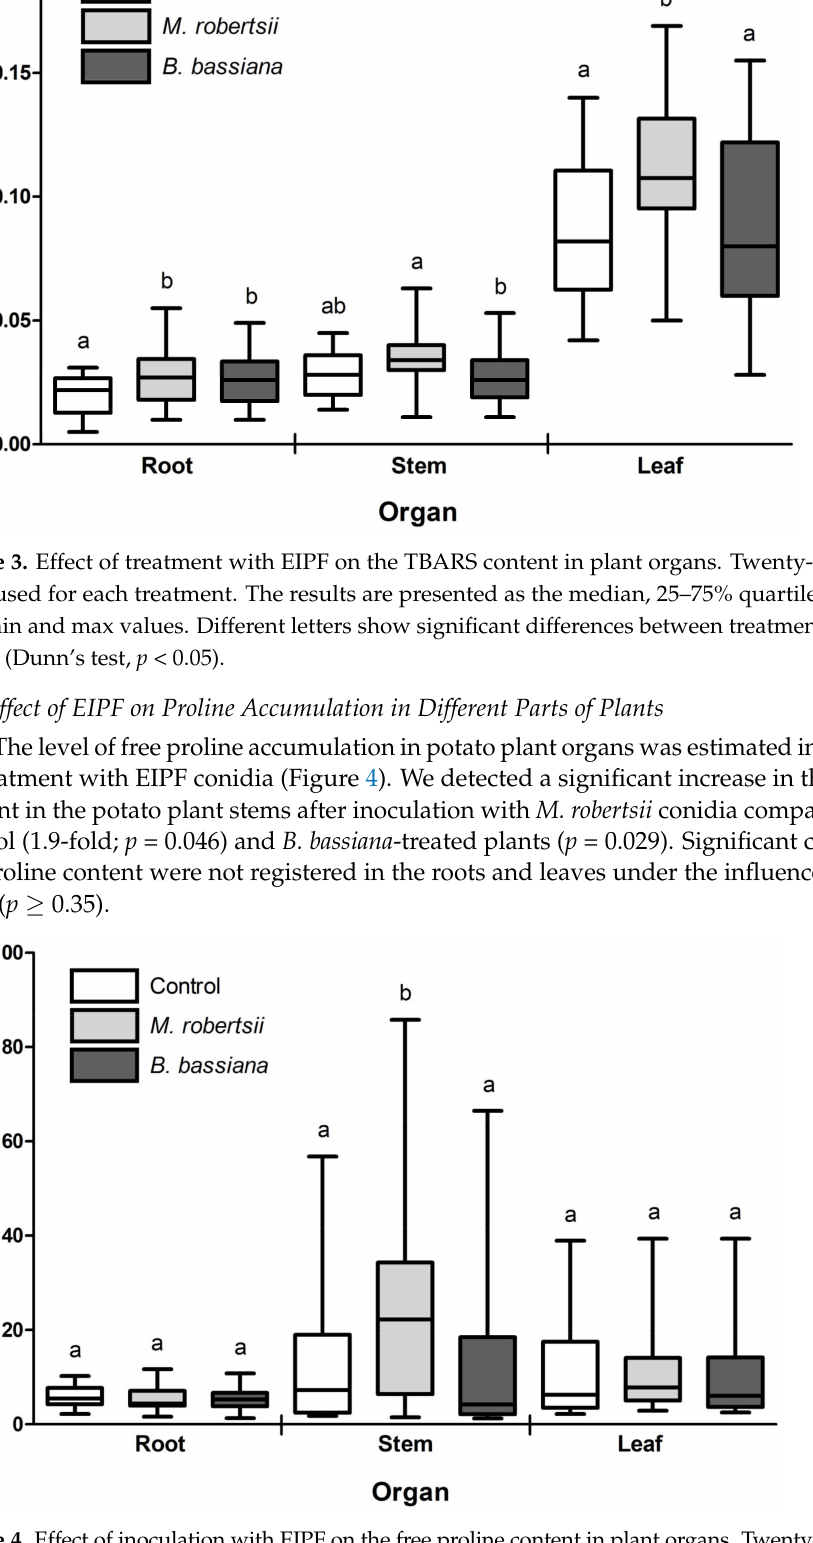
Figure 4. Effect of inoculation with EIPF on the free proline content in plant organs. Twenty-five plants were used for each treatment. The results are presented as the median, 25–75% quartile deviation and min and max values. Different letters show significant differences between treatments for each group (Dunn’s test, p <